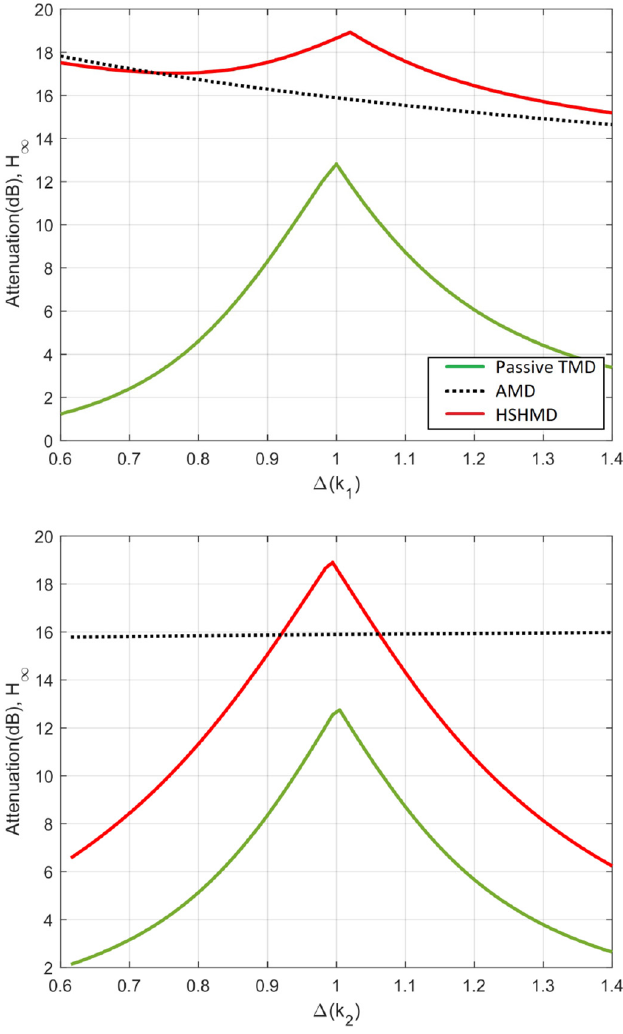
Fig. 6. Evolution of the H ∞ attenuation for (a) a variation on k 1 and (b) a variation on k 2 . Green: Passive TMD. Black dotted line: AMD. Red line: